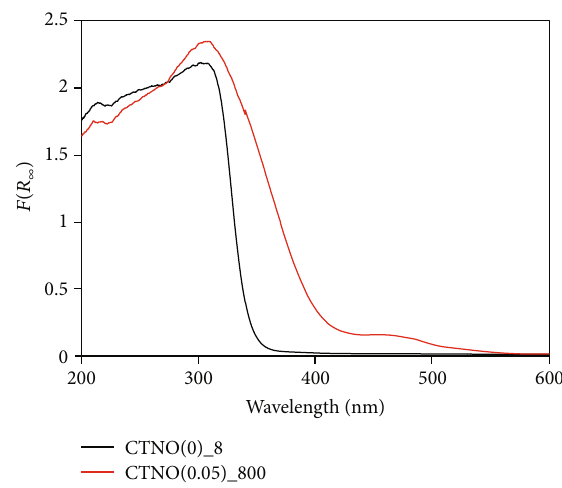
0 : 7 Figure 2: UV-vis DR spectra of CTNO (0)_800 and CTNO (0.05)_